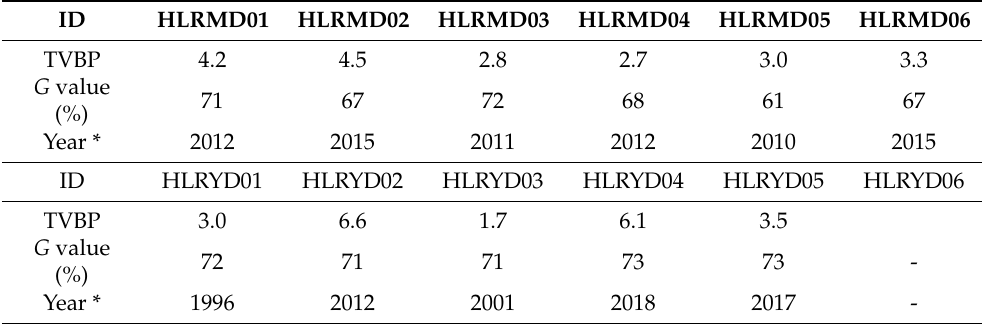
Table 2. Dating the youngest tree rings based on TVBP (T-value Baillie–Pilcher) and G -values between individual ring-width time series of dead shrubs ( R. yedoense (HLRMD) and R. mucronulatum (HLRYD)) and the mean chronology of living